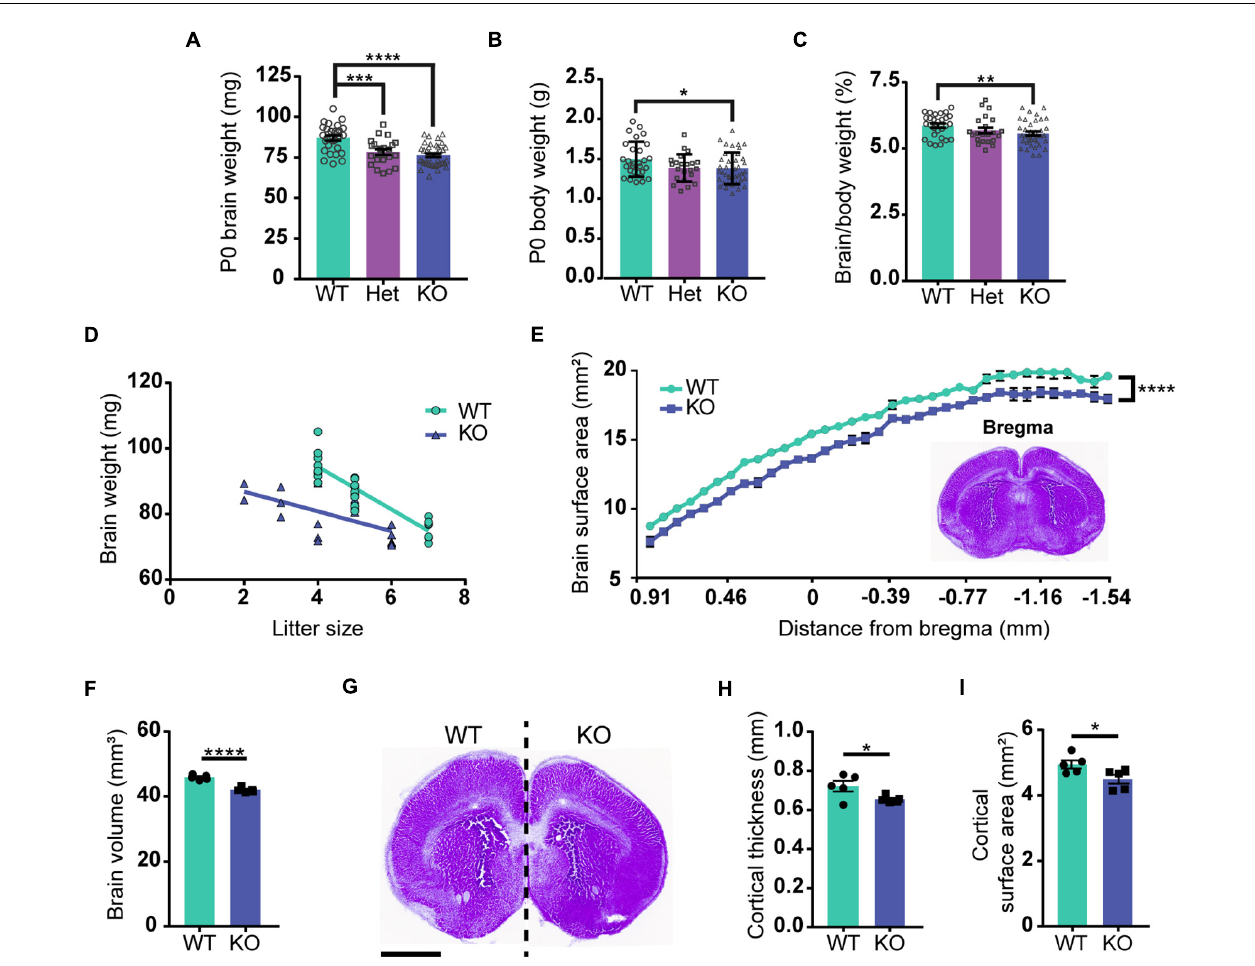
FIGURE 1 | Loss of PARP1 results in reduced brain weight and cortical surface area at birth. (A) Brain weight of wild-type (WT) ( n = 28), PARP1 heterozygous (Het) ( n = 22), and PARP1 KO mice ( n = 39) at birth (P0) shows a reduction in Het and KO mice compared with WT controls. *** p = 0.006; **** p < 0.0001 by Student’s unpaired t -test. (B) P0 body weight is reduced in KO mice compared to WT and Het animals. * p = 0.0315 by Student’s unpaired t -test. (C) The ratio of brain to body weight for each group shows a significant reduction in the relative size of KO brains compared to WT. ** p = 0.0099 by Student’s unpaired t -test. (D) Litter size is inversely correlated with P0 brain weight. WT: R 2 = 0.811, p < 0.0001; KO: R 2 = 0.3725, p = 0.0043. p -Values indicate the significance of correlation within each genotype. Slopes are significantly different ( p = 0.0029). Two-way ANOVA analysis indicated no significant interaction between litter size and genotype ( p = 0.249). (E) Surface area measurement from rostral to caudal portions of the PARP1 KO brain indicates a reduced size throughout the rostral–caudal brain axis. The section designated as bregma is shown in the inset. Distance from bregma for the remaining sections is estimated. **** p < 0.0001 via two-way ANOVA. (F) Brain volume is reduced in PARP1 KO mice. (G) Representative image illustrating reduced brain surface area in PARP1 KO mouse. This section corresponds with bregma 1.045 mm in the adult brain. Scale bar, 1 mm. (H) PARP1 KO reduces cortical surface area and (I) cortical thickness. * p < 0.05; **** p < 0.0001 by Student’s unpaired t -test. Quantification shown represents brain slices corresponding with bregma 1.045 mm in the adult mouse brain. (E–I) n = 5 WT and 5 KO brains from 4